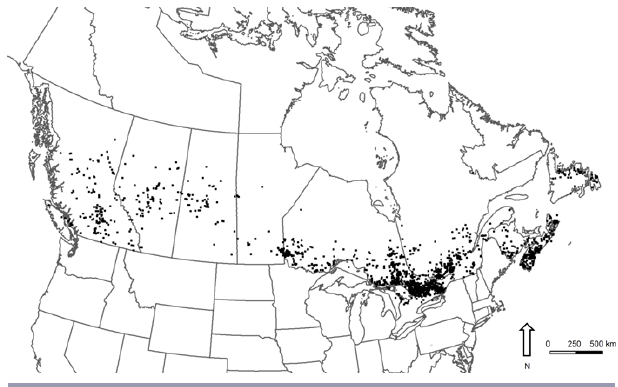
Fig. 1 . Lakes with data collected by participants in